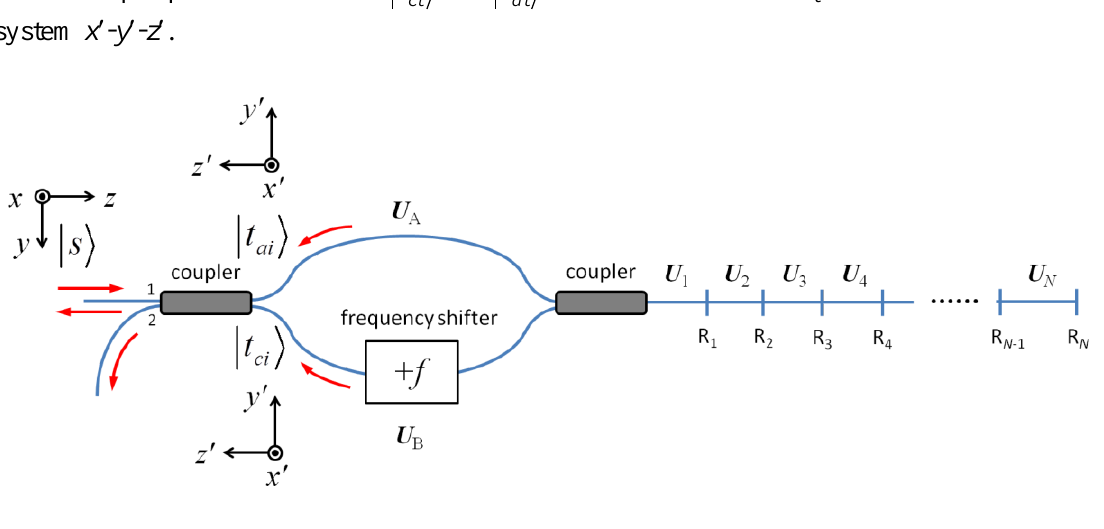
is the local coordinate t from the i th sensor R t and i ci ai